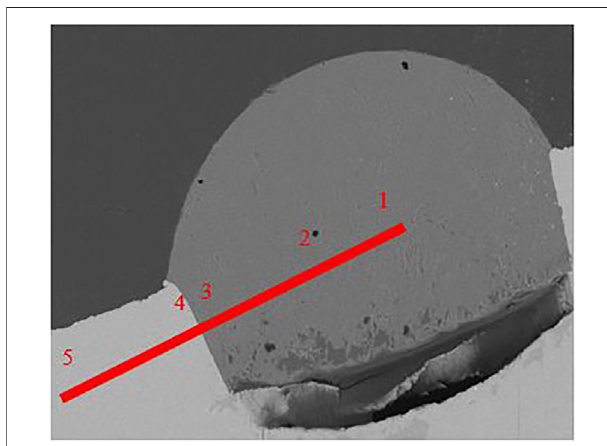
FIGURE 8 | SEM image of the 60 s sample at 1473 K with the point analysis showing the composition of Al and Si.